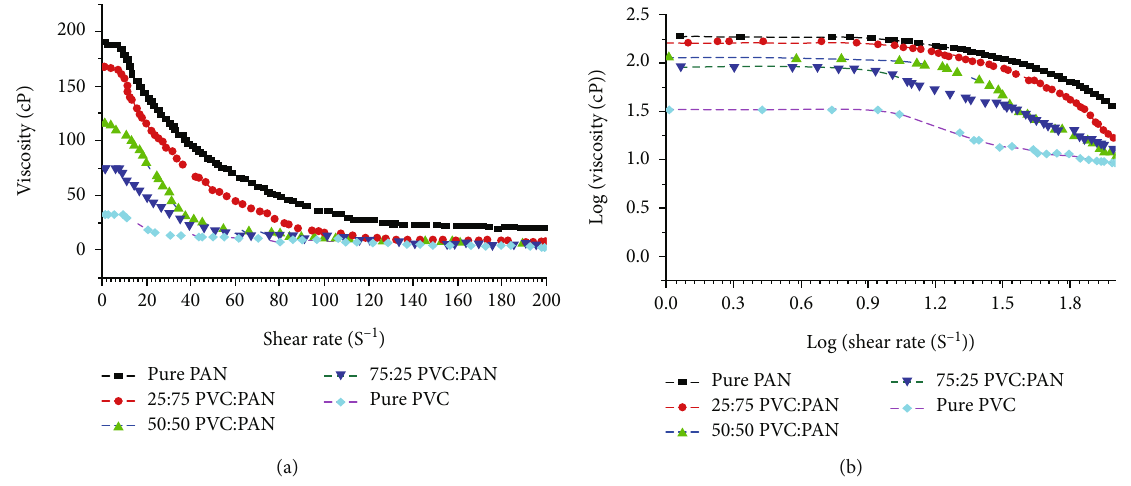
Figure 1: (a) The viscosity-shear rate curves and (b) log viscosity-log shear rate curves according to Carreau model of pure PVC, pure PAN, and PVC: PAN blending ratio solutions.